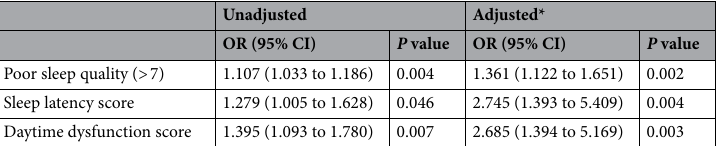
Table 2. Risk of thyroid malignancy according to sleep quality. *Adjusted for sex, age, duration, BMI, BP, UA, thyroid function, SAS and SDS score. OR odds ratio; CI confidence interval; PSQI Pittsburgh Sleep Quality